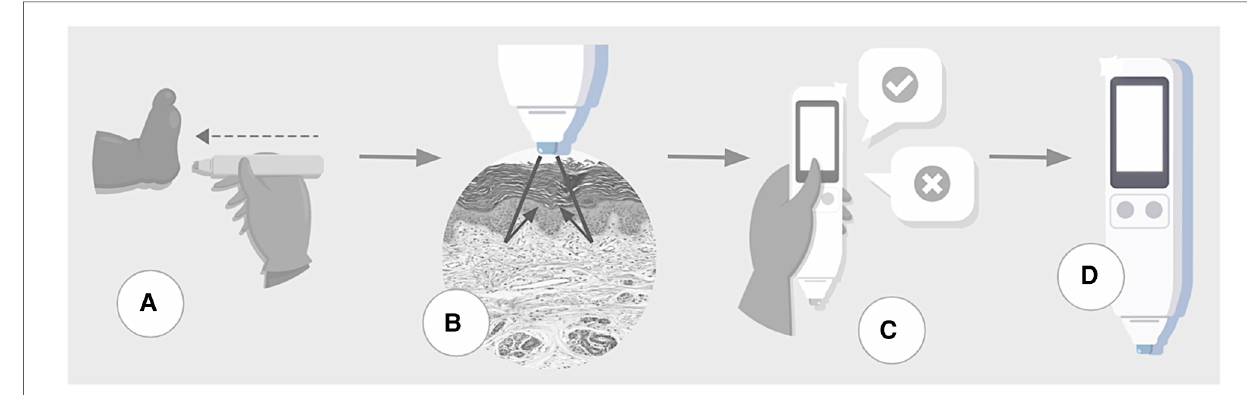
FIGURE 1 Steps of testing process. ( A ) The device touches the skin over the sole of a newborn. ( B ) The sensor acquires skin maturity by assessing the photobiological properties of the tissue by measuring the re fl ection portions of the light beam incident on the skin. ( C ) The user inputs clinical data. ( D ) Data processor uses machine learning algorithms to estimate gestational age and classify the infant as preterm or term, small-for-gestational-age or